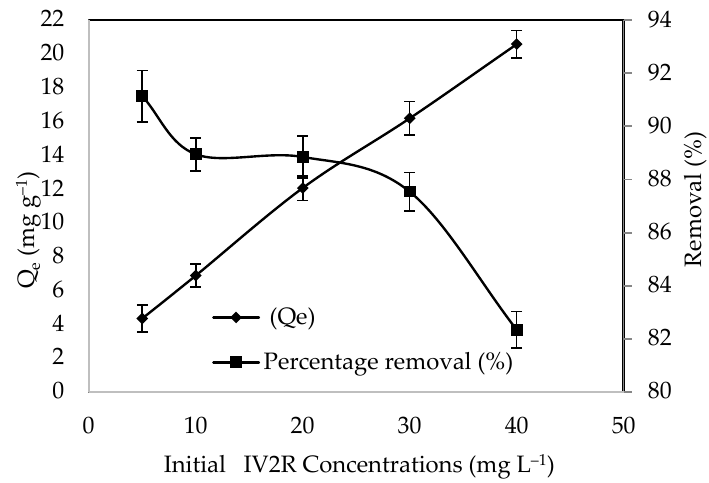
Figure 7. Influence of the initial IV2R dye concentration.